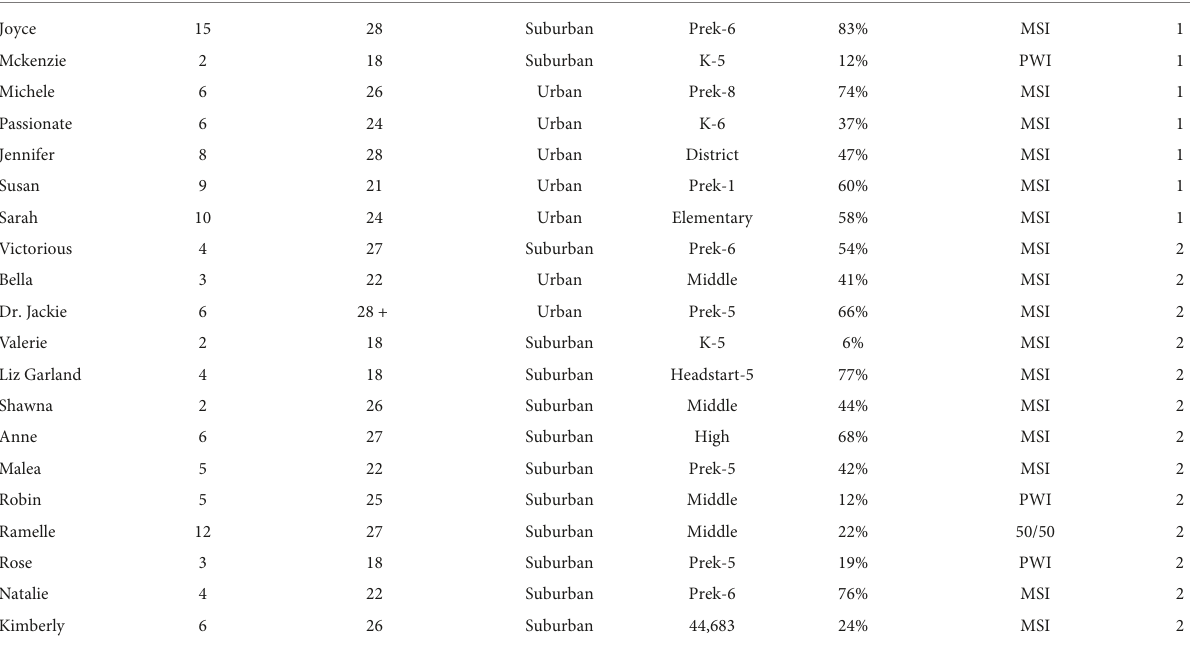
TABLE 1 Select principal